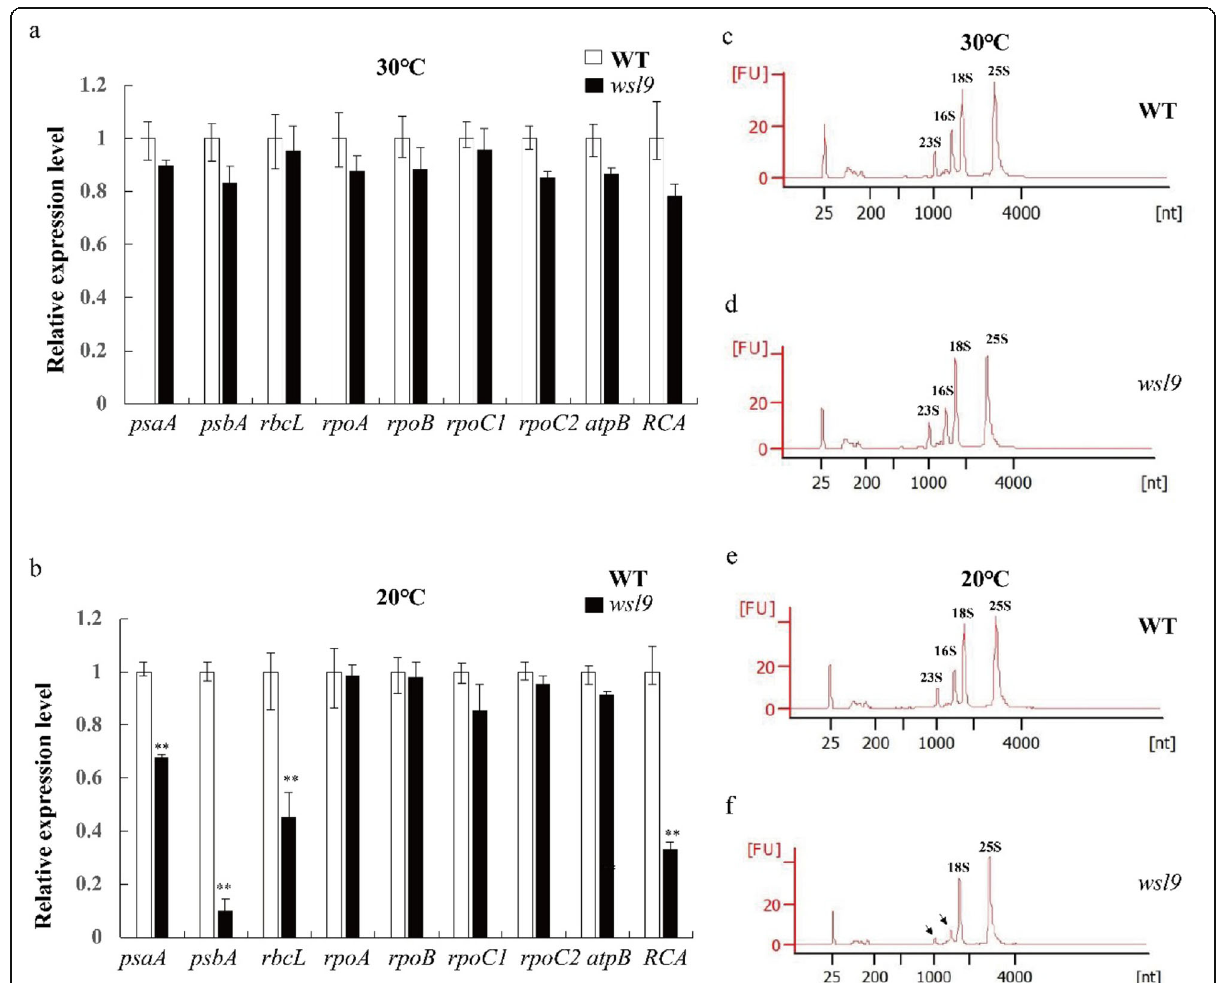
Fig. 6 Accumulation of transcripts of chloroplast-associated genes in WT and wsl9 seedlings. a , b qRT-PCR analysis of relative expression levels of plastidic encoding genes in wild type and wsl9 mutant at the third-leaf stage at ( a ) 30 °C and ( b ) 20 °C. Error bars represent SD from three independent experiments. c-f rRNA analysis using an Agilent 2100 analyser. RNA was isolated from third-leaf stage WT and wsl9 mutant seedlings grown at 30 °C and 20 °C. (Student ’ s t -test, ∗∗ , P <